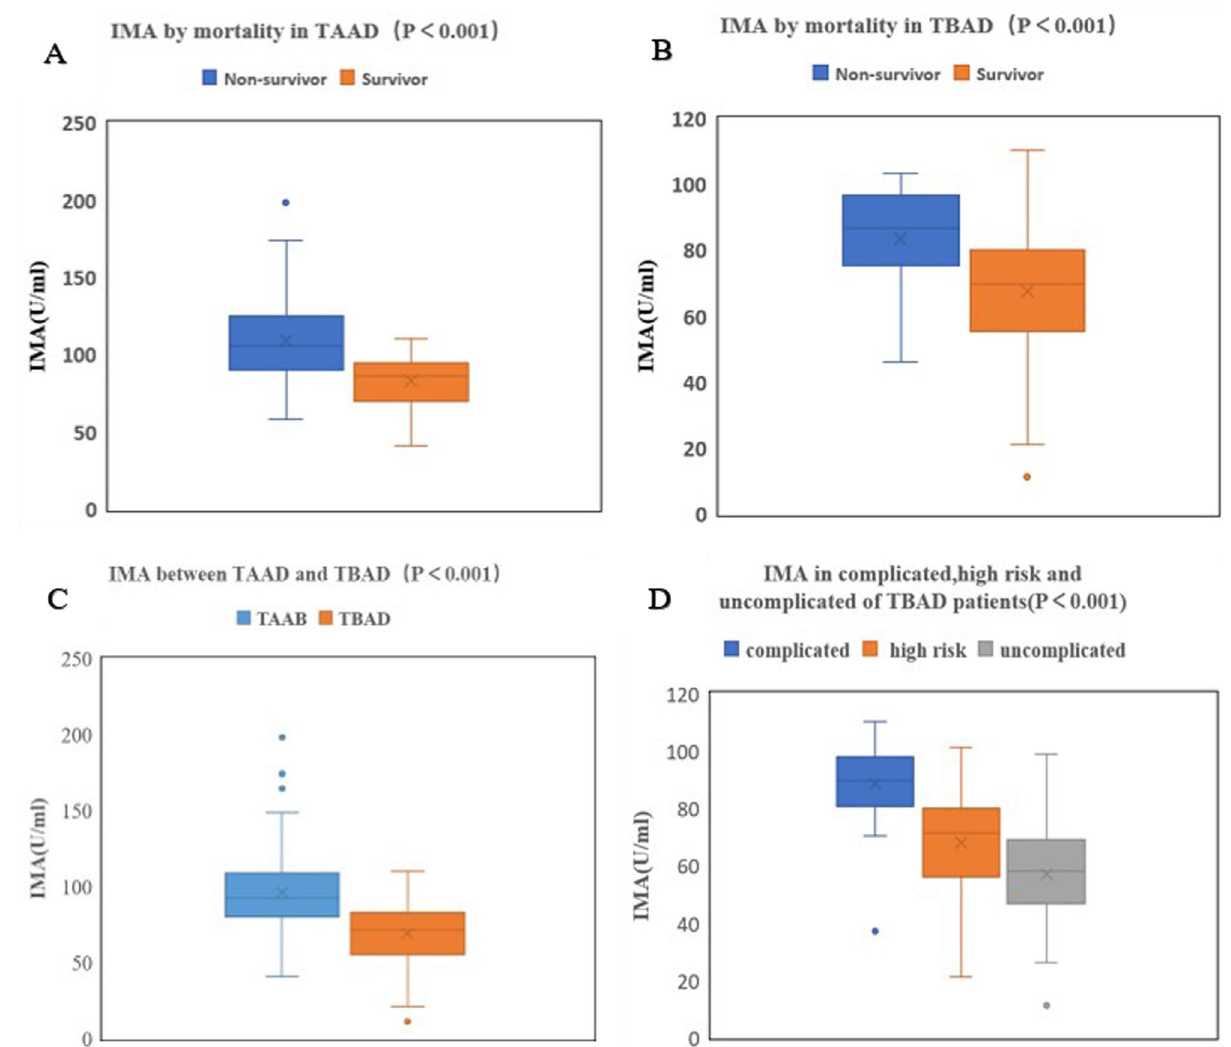
Figure 2. Comparison of IMA between different groups. ( A ) Shows IMA between non-survivor group and survivor group in TAAD. ( B ) Shows IMA between non-survivor group and survivor group in TBAD. ( C ) Shows IMA between TAAD and TBAD. ( D ) Shows IMA between complicated dissection, high risk dissection and uncomplicated dissection. IMA, Ischemia-modified albumin; TAAD, Stanford type A aortic dissection; TBAD, Stanford type B aortic dissection. The bottom and top edges of each box represent the first and third quartiles, respectively, the band within the box represents the median